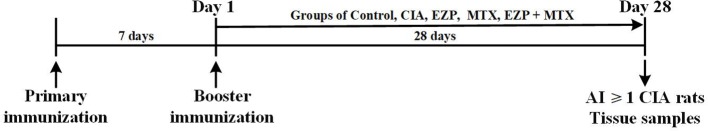
Experimental schedule. Male SD rats were immunized twice by intradermal injection with 50 µL bovine type II collagen emulsified with IFA on 7 days before day 1 and day 1. On day 1, the rats were randomly assigned into groups CIA, EZP, MTX, and EZP + MTX and given intragastric administration for 28 days. Tissue samples of the control rats and rats with AI ≥ 1 in the model were collected at the end-point of the experiment (day 28).